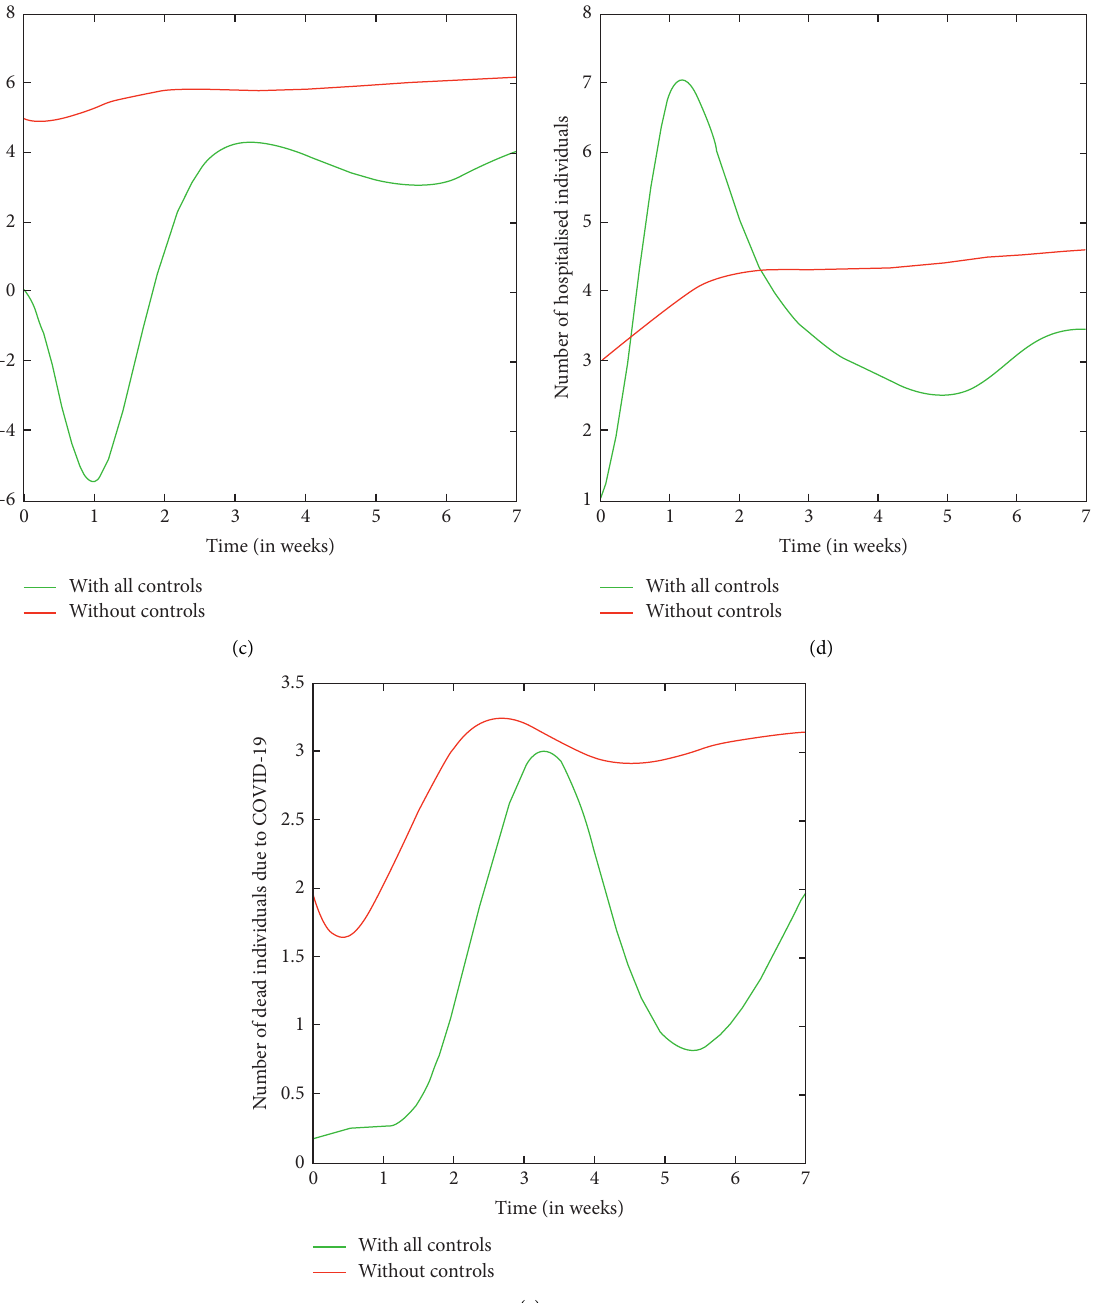
Figure 4: Variation in compartments with and without optimal